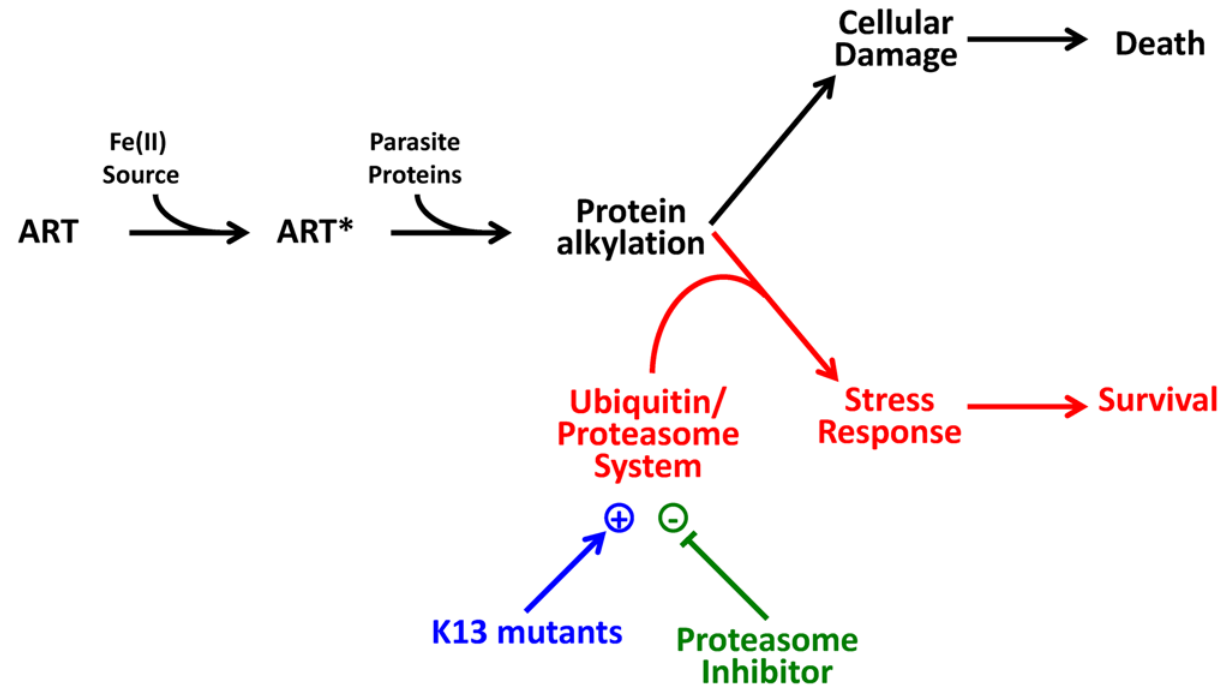
Fig 8. Model of killing and survival-promoting events following treatment with ART. ART is activated by an Fe(II) source (e.g., heme released from hemoglobin degradation or from the cellular labile iron pool) to produce activated ART (ART * ), which is reactive, leading to cellular damage and ultimately to parasite death (shown in black). The parasite mounts a stress response, that manifests as growth retardation and engagement of the proteasome-ubiquitin pathway (shown in red). The stress response in K13 mutants is enhanced (shown in blue). In contrast, epoxomicin inhibits the stress response (shown in green), thus promoting parasite